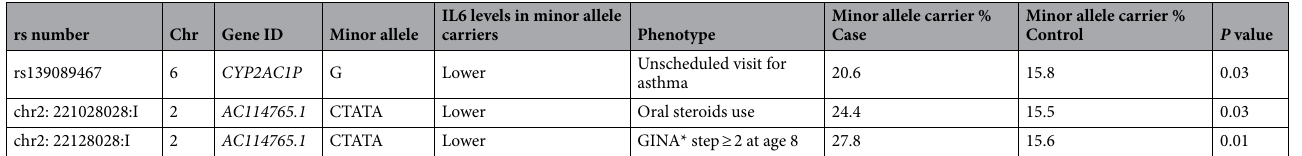
Table 3. Clinical phenotypes associated with IL-6 cQTLs. * GINA Global Initiative for Asthma; step 1 treatment is used for mild intermittent asthma. Step 2 treatment or above is required to treat more severe